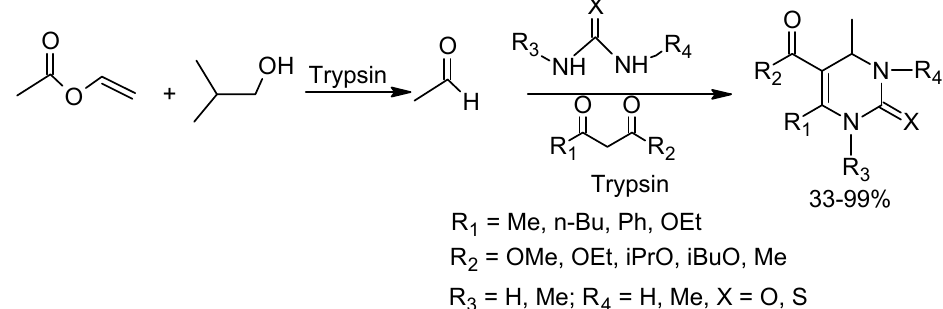
Scheme 7. Enzyme in-situ generation of acetaldehyde in the Biginelli reaction.